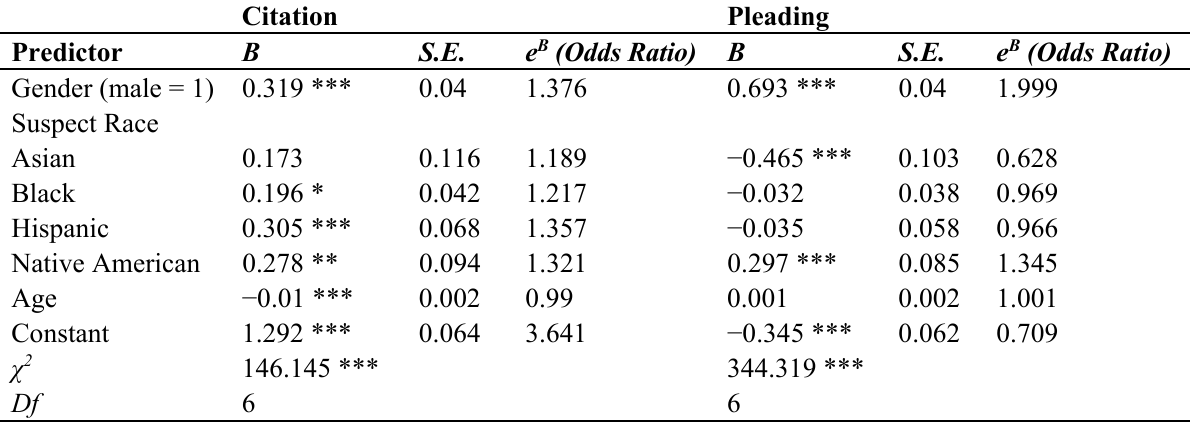
Table 1. Summary of logistic regression analysis for variables predicting citation (No =